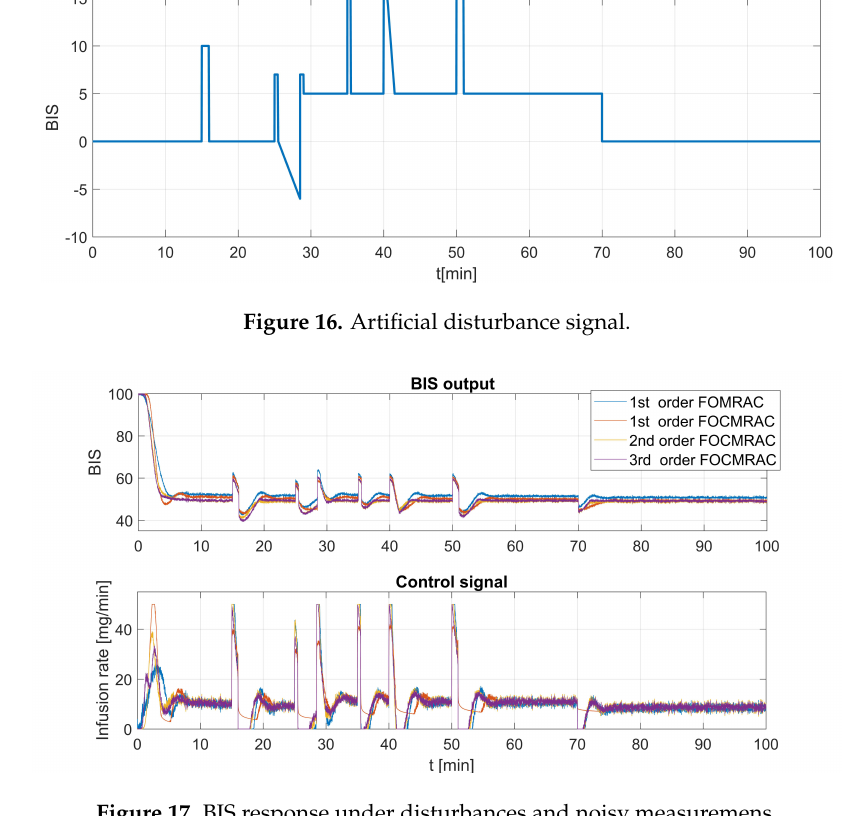
Figure 17. BIS response under disturbances and noisy measuremens.